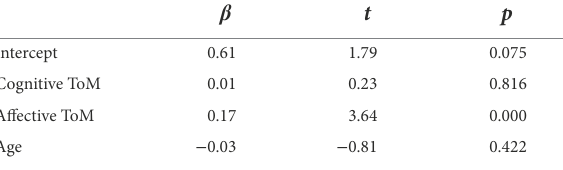
TABLE 9 Results of the multiple linear regression with material vs. mental arguments indicator (response variable) and the cognitive ToM and affective ToM dimensions (independent variables), the covariate being the age